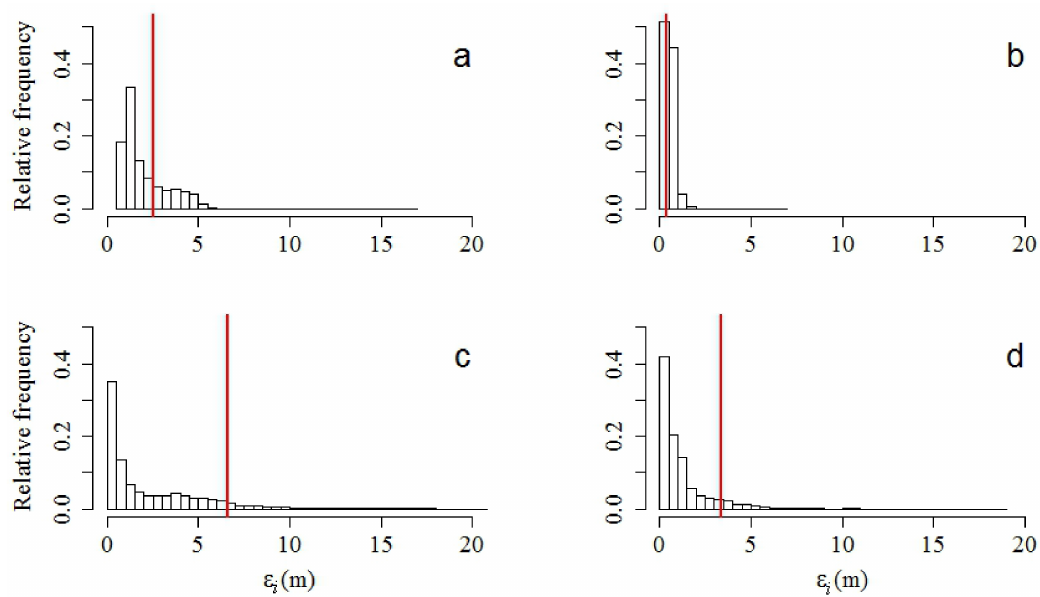
Figure 8. Histograms of ε i , which is equal to the summed M3C2 difference (PC dist-i ) and 95% distance uncertainty ( u i ) M3C2 output after amalgamation for the SfM point cloud comparisons of ( a ) i1 and ( b ) i2, and TLS point cloud comparisons of ( c ) i1 and ( d ) i2. The red vertical lines represent the level of detection (DDT) for each survey